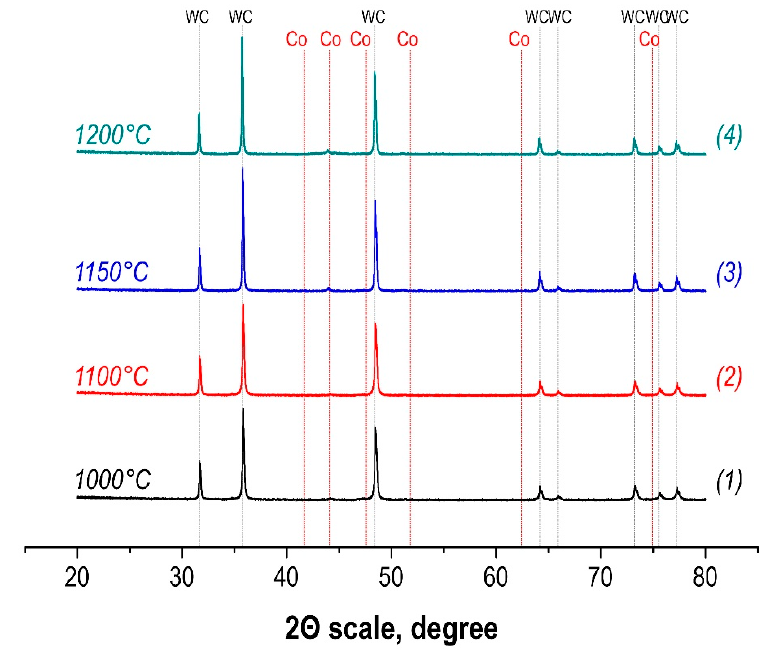
Figure 3. Phase composition of WC-10wt%Co hard alloys obtained by SPS-consolidation at different temperatures (1000, 1100, 1150, 1200 °C).